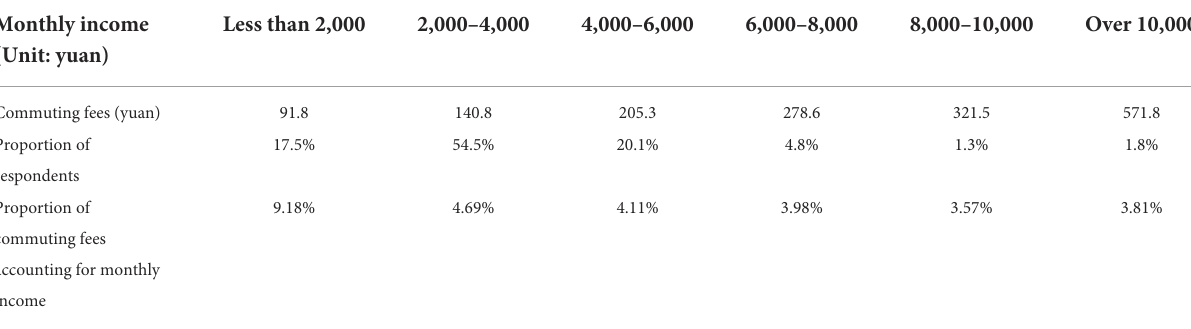
TABLE 7 The proportion of respondents’ monthly income and commuting fees.